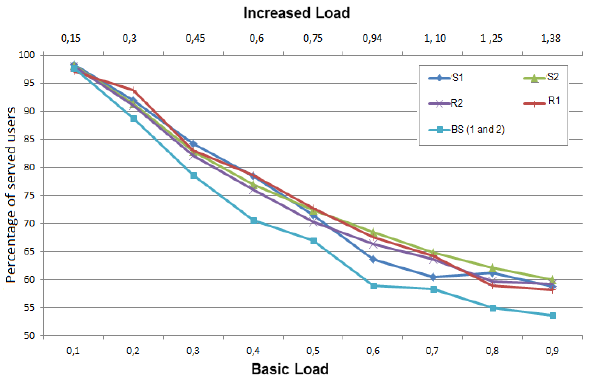
Figure 5: Percentage of satisfied mobile users.